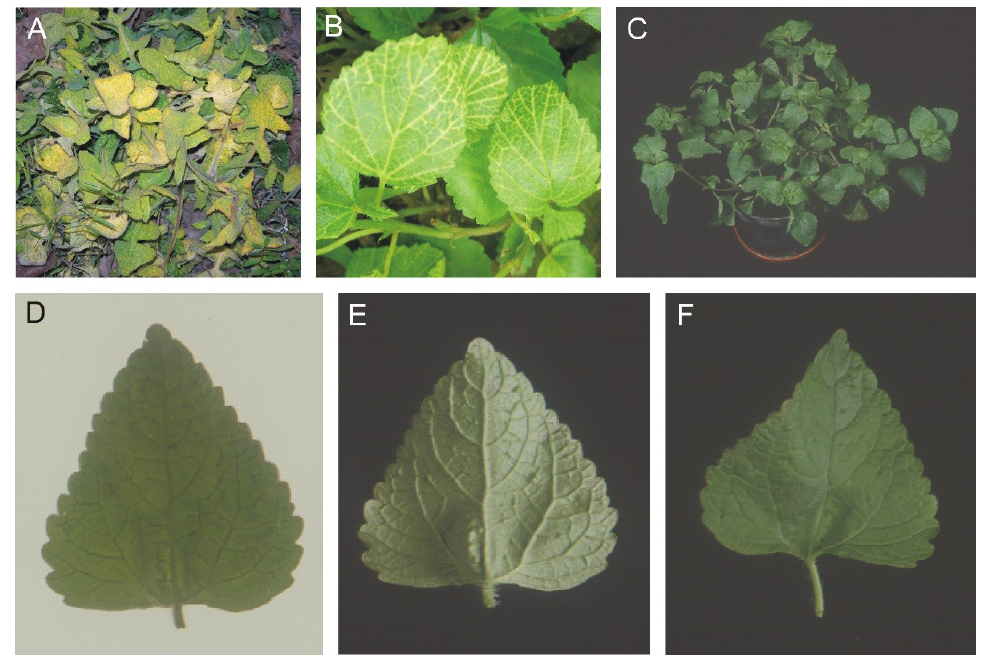
Figure 1. Symptoms exhibited by the plants from which AEV clones were obtained. Sonchus oleraceous with yellow veins ( A ) Ageratum conyzoides with yellow veins ( B ), A. conyzoides from Nepal ( C ). A leaf from the A. conyzoides plant from Nepal is photographed under transmitted light to highlight the vein darkening ( D ) and under reflected light on the underside ( E ) and upper side ( F ) to highlight the dimple